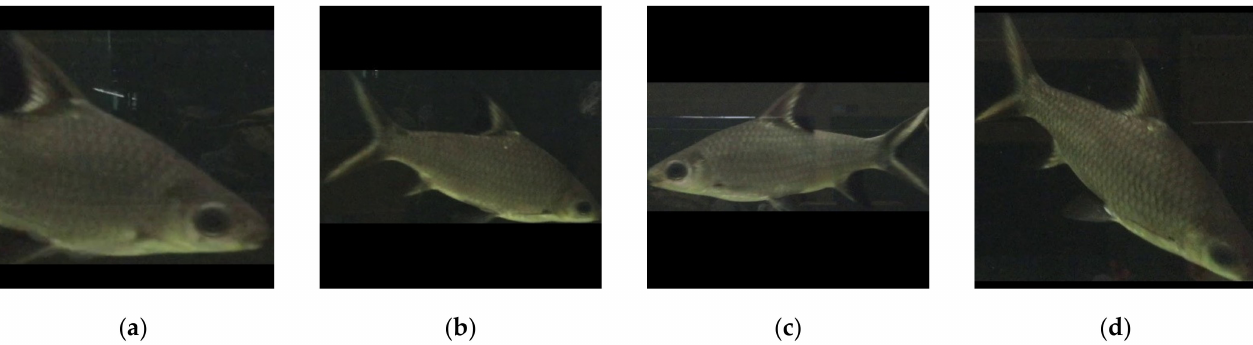
Figure 2. Sample standardized aquatic object images with various appearances: ( a ) partial body, ( b ) full body, ( c ) body with nose, and ( d ) diving